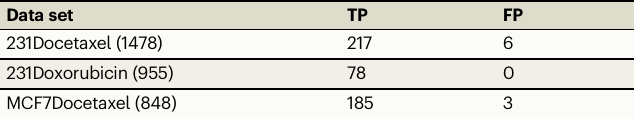
Table 1 | Segmentation error prediction on the test data